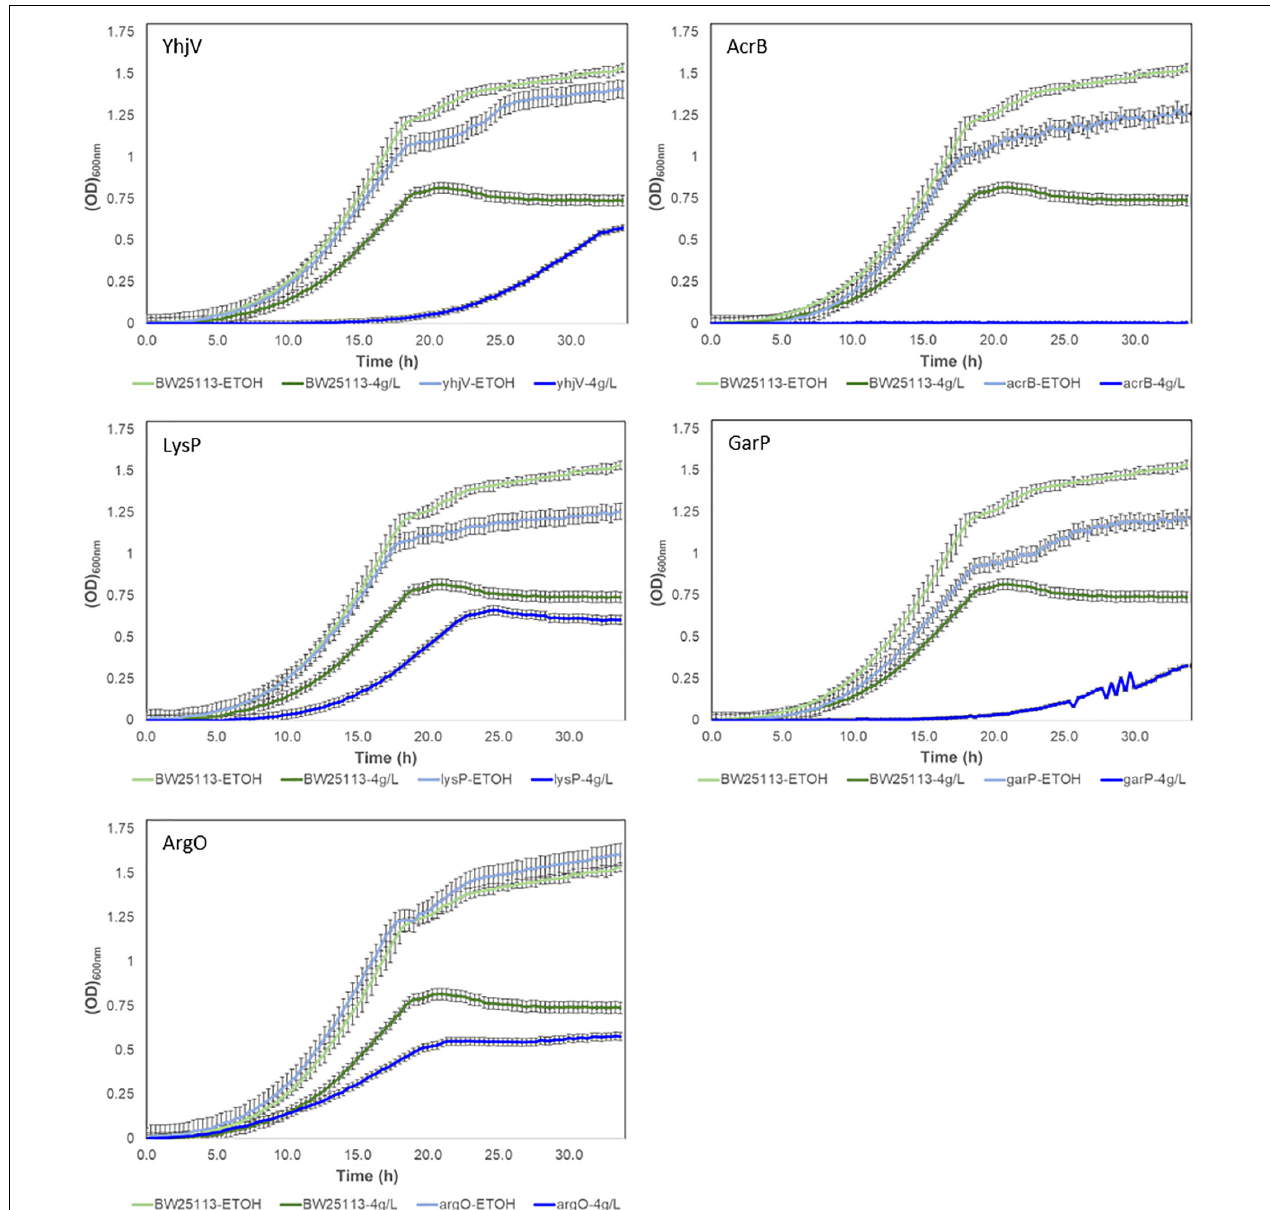
FIGURE 4 | Growth of Keio transporter knockouts in the presence of 4 g/L of melatonin in M9 glucose media. BW25113 (wild-type strain of the Keio knockouts) was used as a control strain. All strains were cultivated in the presence of 4% melatonin and 4% ethanol ( − 4 g/L). The control condition is the medium supplemented with only 4% ethanol